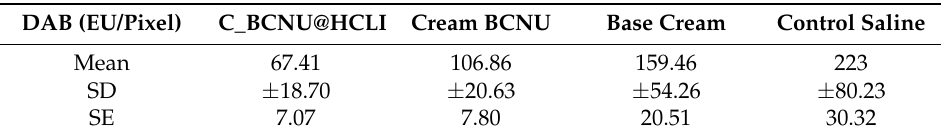
Table 7. Cox-2 expression level: quantitative intensity of the chromogen (DAB) expressed as EU/pixel of the new formulation and the control type treatments; (TIFFalyzer).